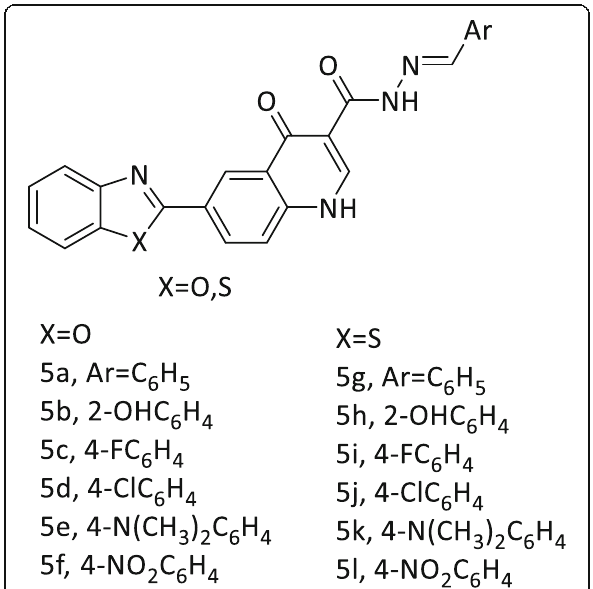
Fig. 37 Benzoxazole/benzothiazole quinolone compounds